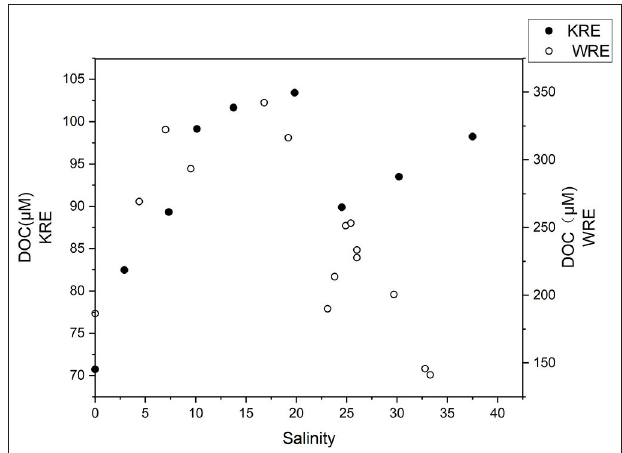
FIGURE 4 | Dissolved organic carbon (DOC) variation vs. salinity of the surface waters in the WRE and the KRE. Note the y-axes of the two estuaries are on different